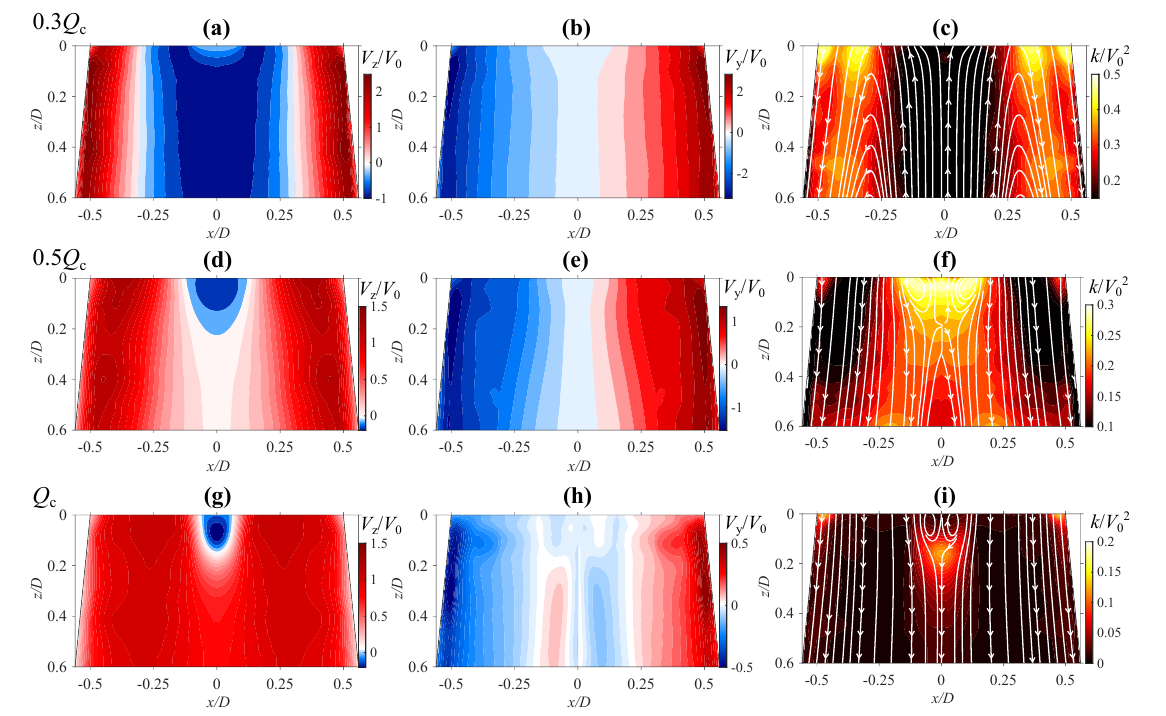
Figure 4. Mean axial ( a , d , g ) and mean tangential ( b , e , h ) components of velocity, and TKE distribu- tions ( c , f , i ) for 0.3 Q c , 0.5 Q c , and Q c